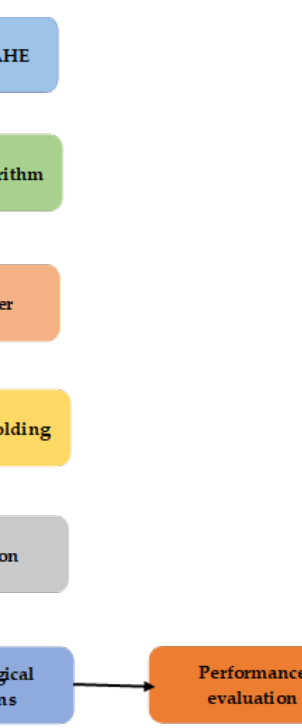
Figure 4. Proposed methodology for blood vessel segmentation.